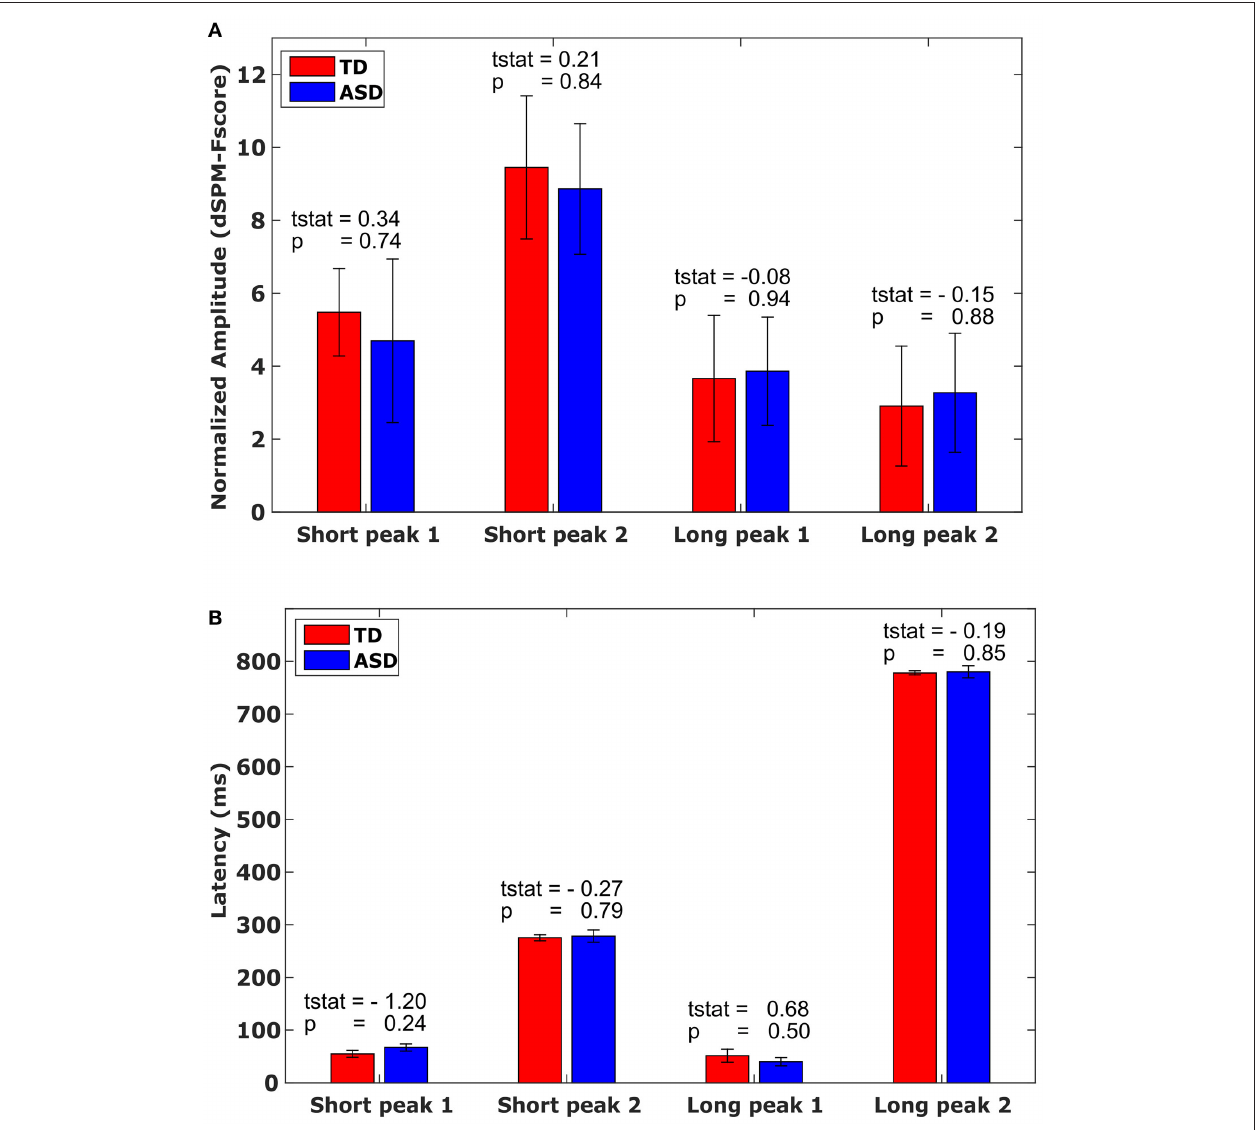
FIGURE 2 | Amplitude and Latency. (A) Mean amplitude values with associated standard error for each M40 peak in the short and long evoked response conditions, by group, averaged across the time window marked in Figures 1C,D . (B) Mean latency values with associated standard error for each M40 peak in the short and long evoked response condition, by group. Bars mark the standard